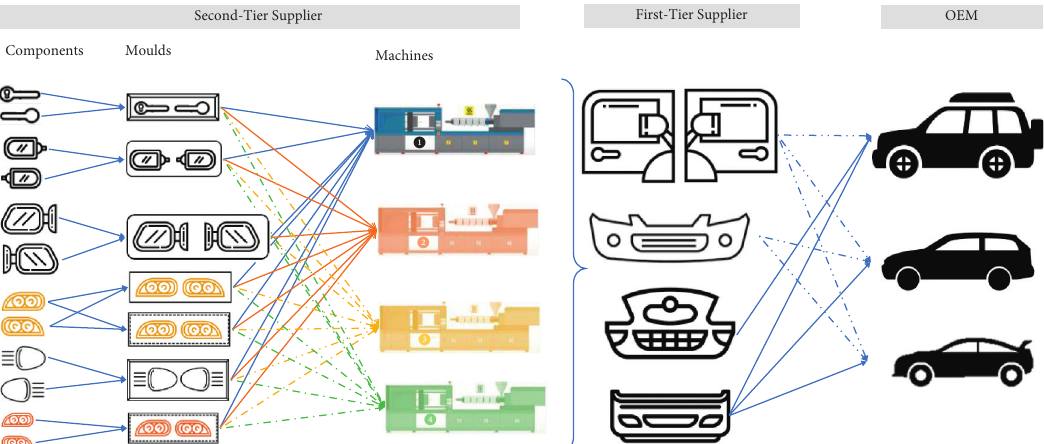
Figure 1: Production scheme on parallel flexible injection machines of plastic components in the automotive supply